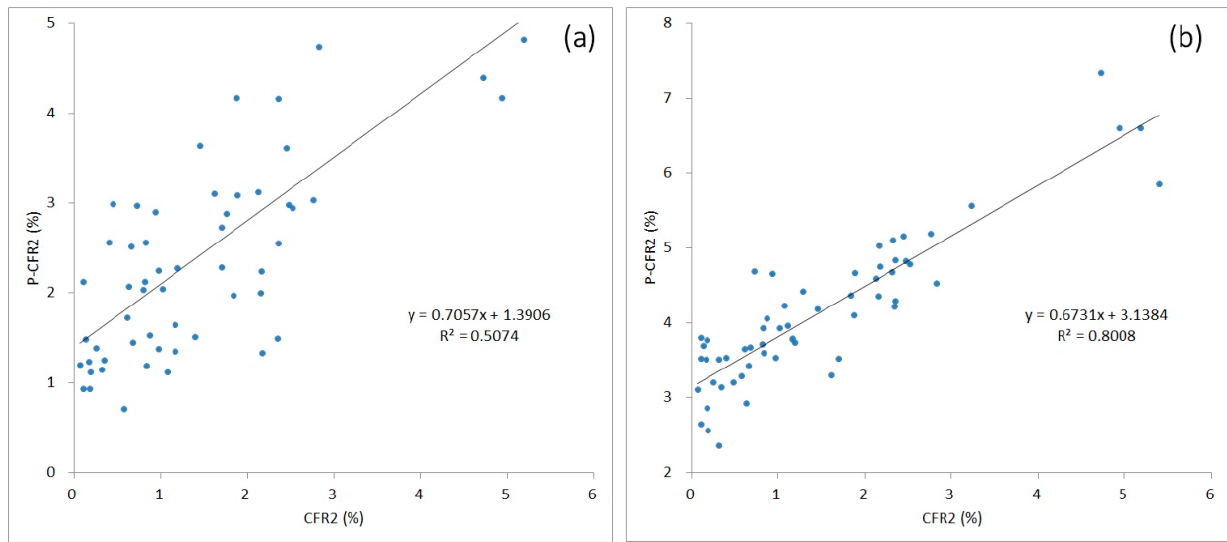
Figure 5. Prediction performances of CFR2 with two models for initial COVID-19 epidemics for internal evaluation. CFR2 values: calculated from existing national CFR curves. Predicted CFR2 (p-CFR2) values: estimated from model M1 ( a ) and model M2 ( b ). With model M2, CFR2 was predicted successfully for 59 nations and regions based on the nine national indicators (R 2 = 0.8008) (Figure 5b). RMSE was 0.6562% and MAE was 0.5107%. RAE was 0.5017 and RRSE was 0.5092. There was poor prediction performance for six nations and regions including Ecuador, France, Lebanon, Lithuania, Russia, and Turkey. All the R 2 values of 3DMA-CFR curves for those six nations and regions showed relative lower. The R 2 values of Turkey and Ecuador were 0.8445 and 0.8752,